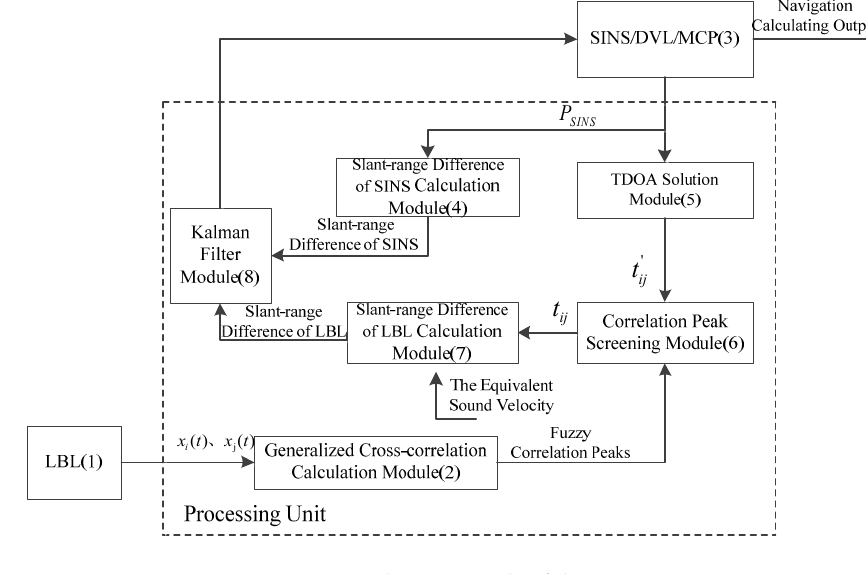
Figure 2. Working principle of the system.